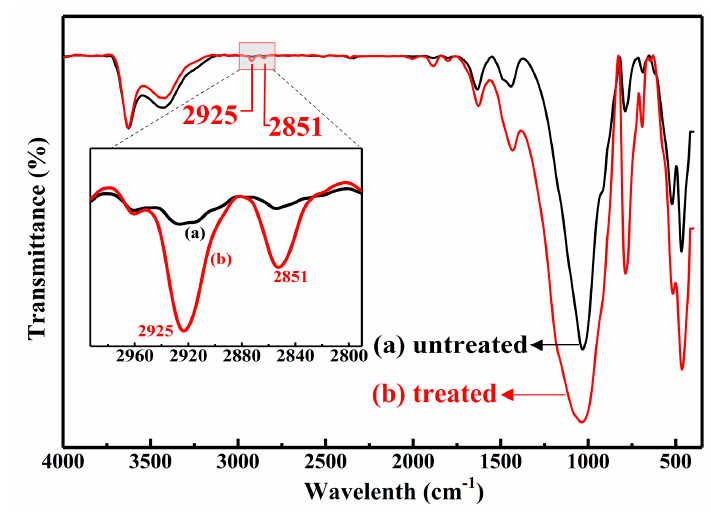
Figure 4. FT-IR specta of FD and mFD particles.